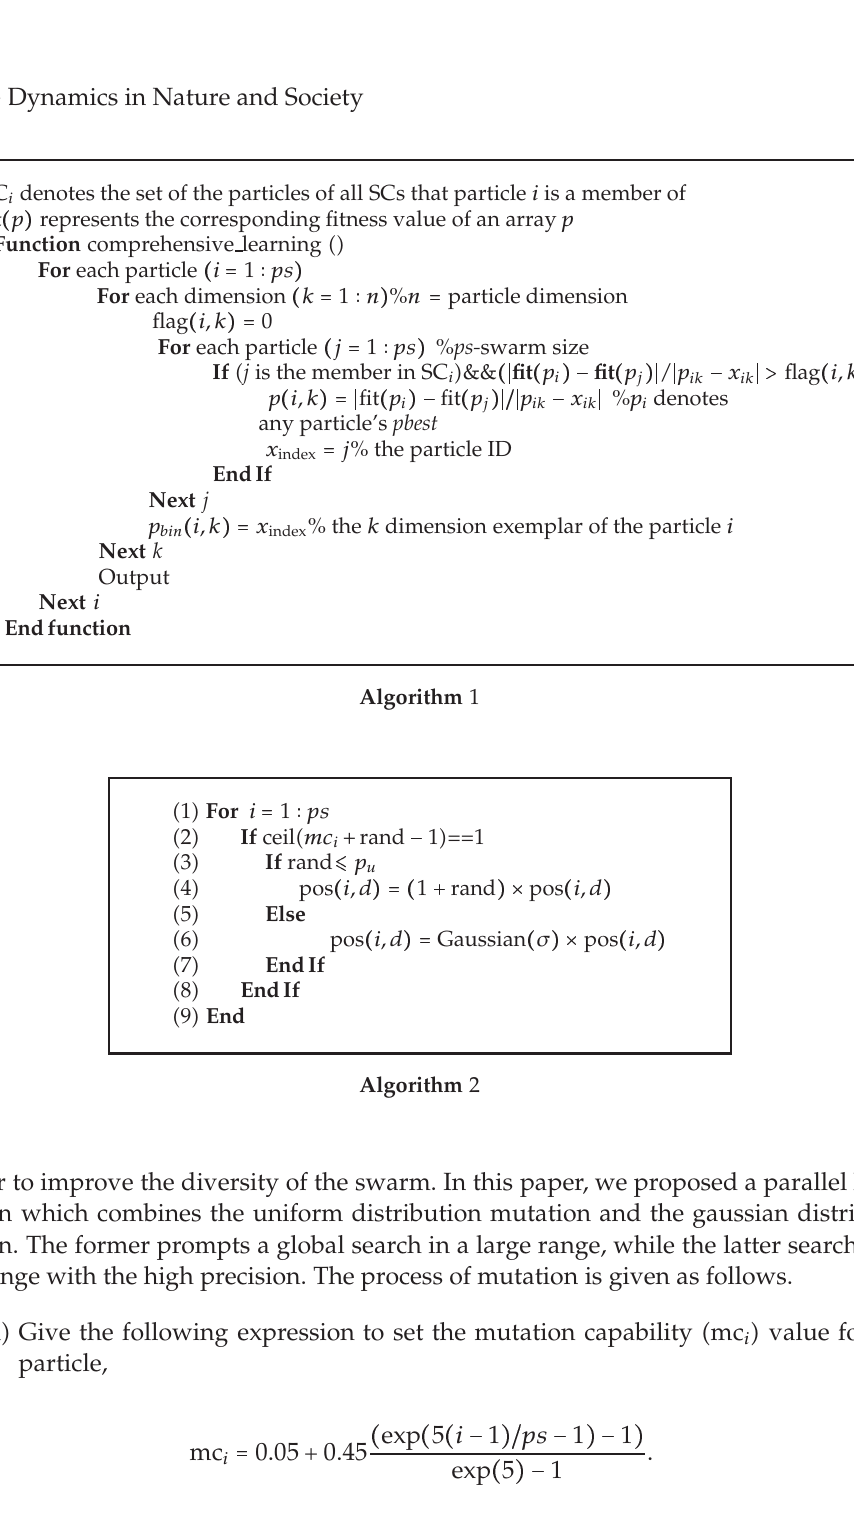
Figure 4 (cid:2) b (cid:3) shows an the example of mc assigned for 40 particles. Each particle has a mutation ability ranging from 0.05 to